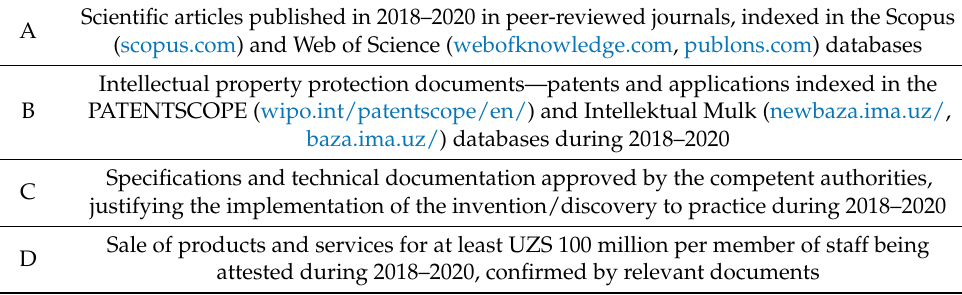
Table 2. Category of attestation